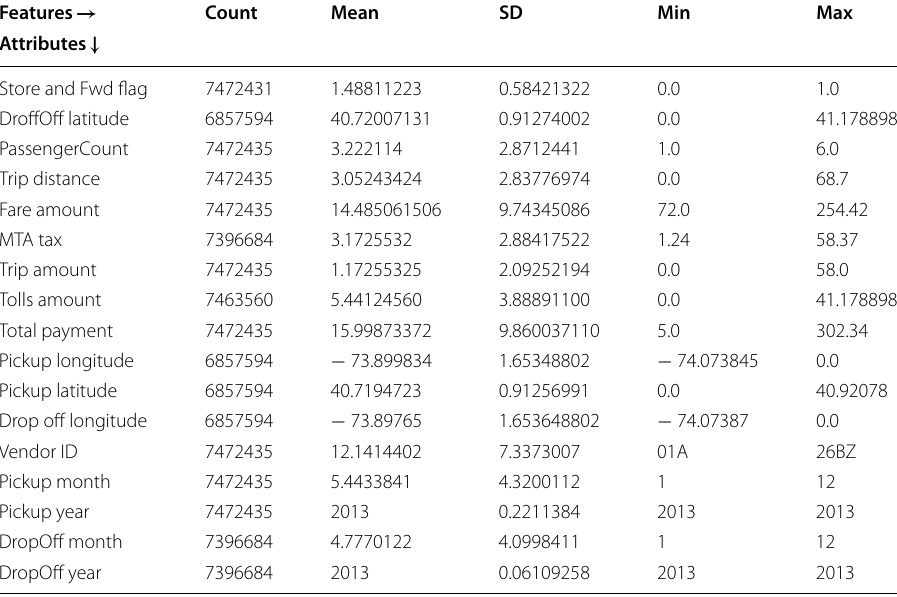
Table 6 Statistical features of the dataset c Features